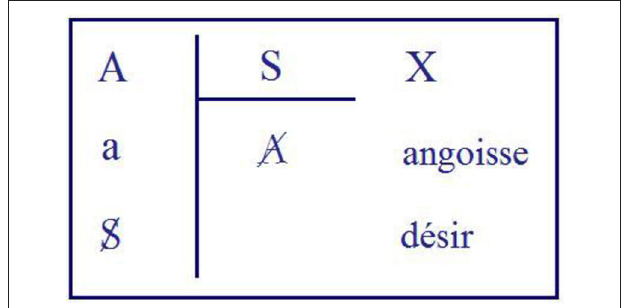
FIGURE 1 | Second schema of subject’s division, J. Lacan, seminar